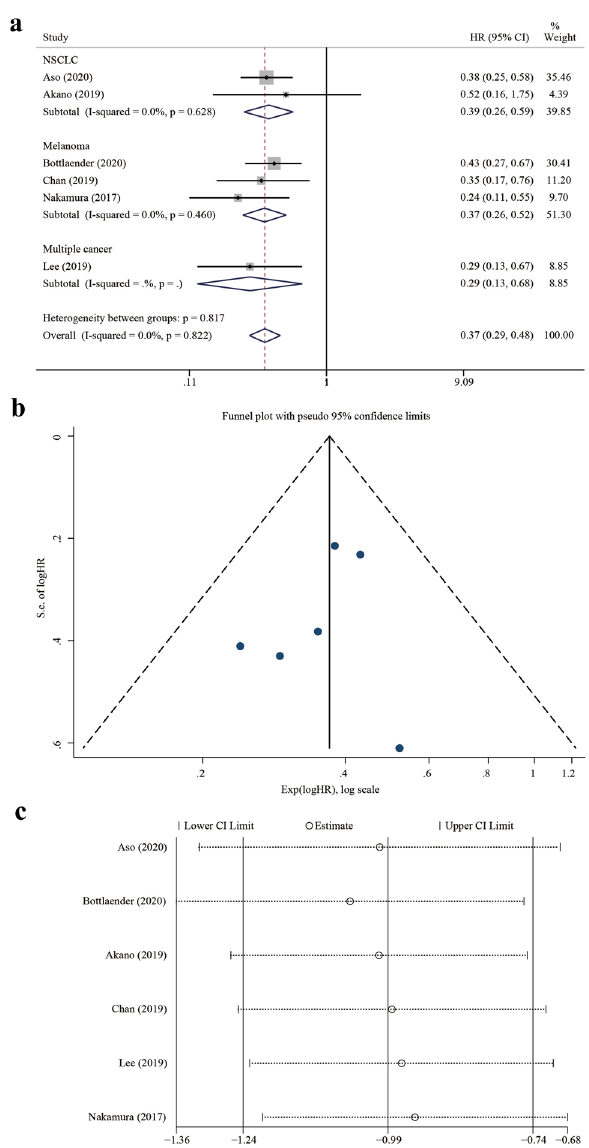
Figure 4. Forest plot showing the association between irCAE occurrence and PFS, publication bias analysis, and sensitivity analysis. ( a ) Subgroup analysis among cancer types and PFS. ( b ) Funnel plot of the PFS. ( c ) Sensitivity analysis of the PFS. IrCAEs, immune-related cutaneous adverse events; PFS, progression-free survival; HR, hazard